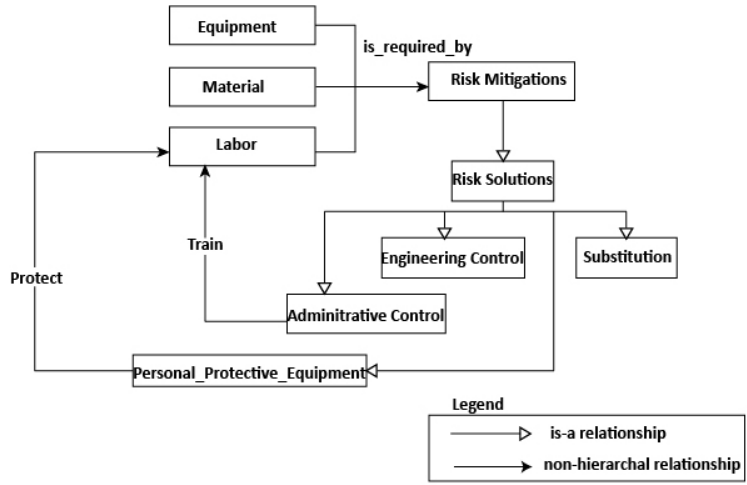
Figure 4. Risk Mitigation Class in the HSM-Onto.